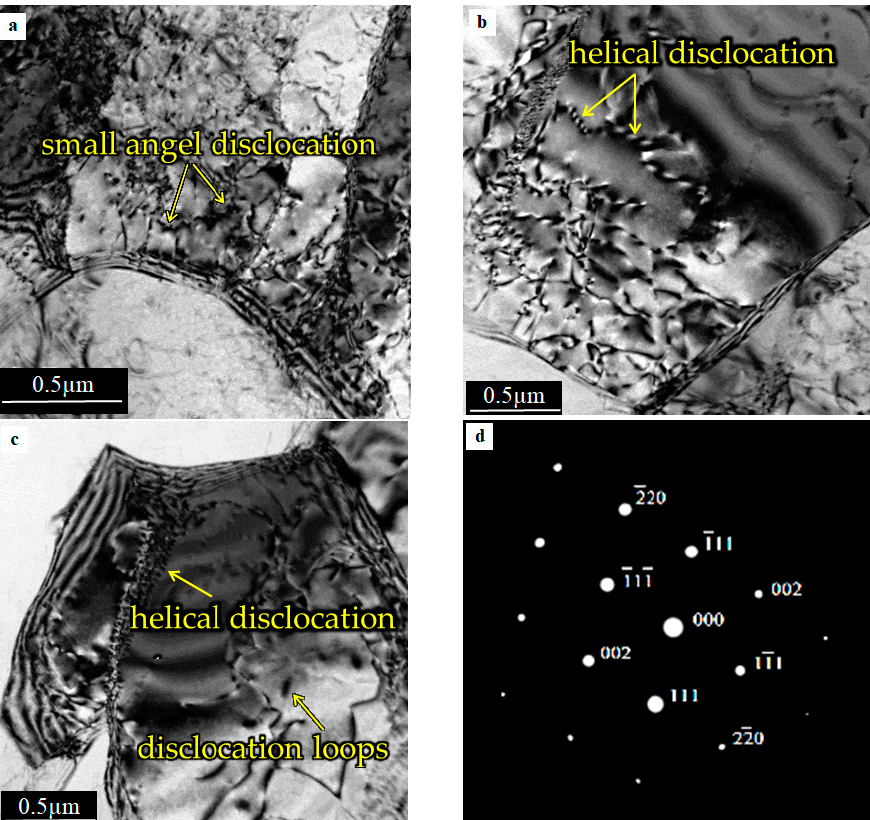
Figure 11. TEM microstructure in the aluminum specimen laying in the immediate vicinity of the weld interface: ( a – c ) relatively small grains divided with a high angle the grain boundaries, ( d ) selected diffraction pattern (SAD) from dark grain is shown in Figure 11c (zone axis